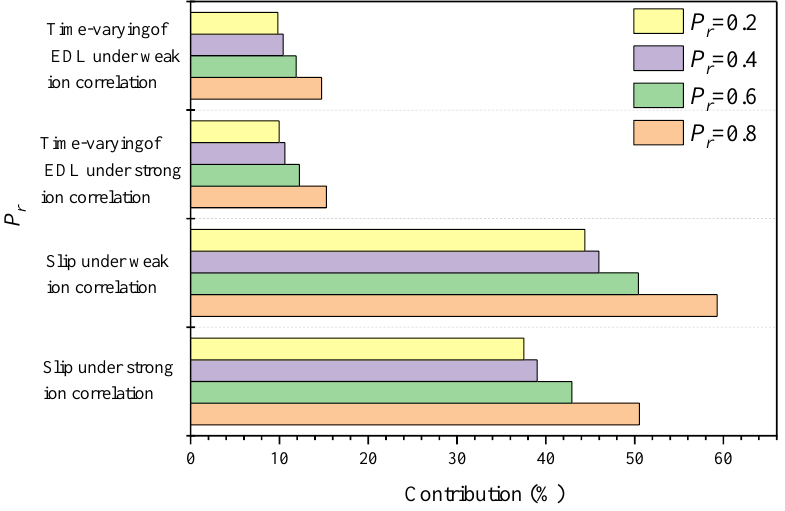
Figure 16. Contribution of interface effect under combined factors.